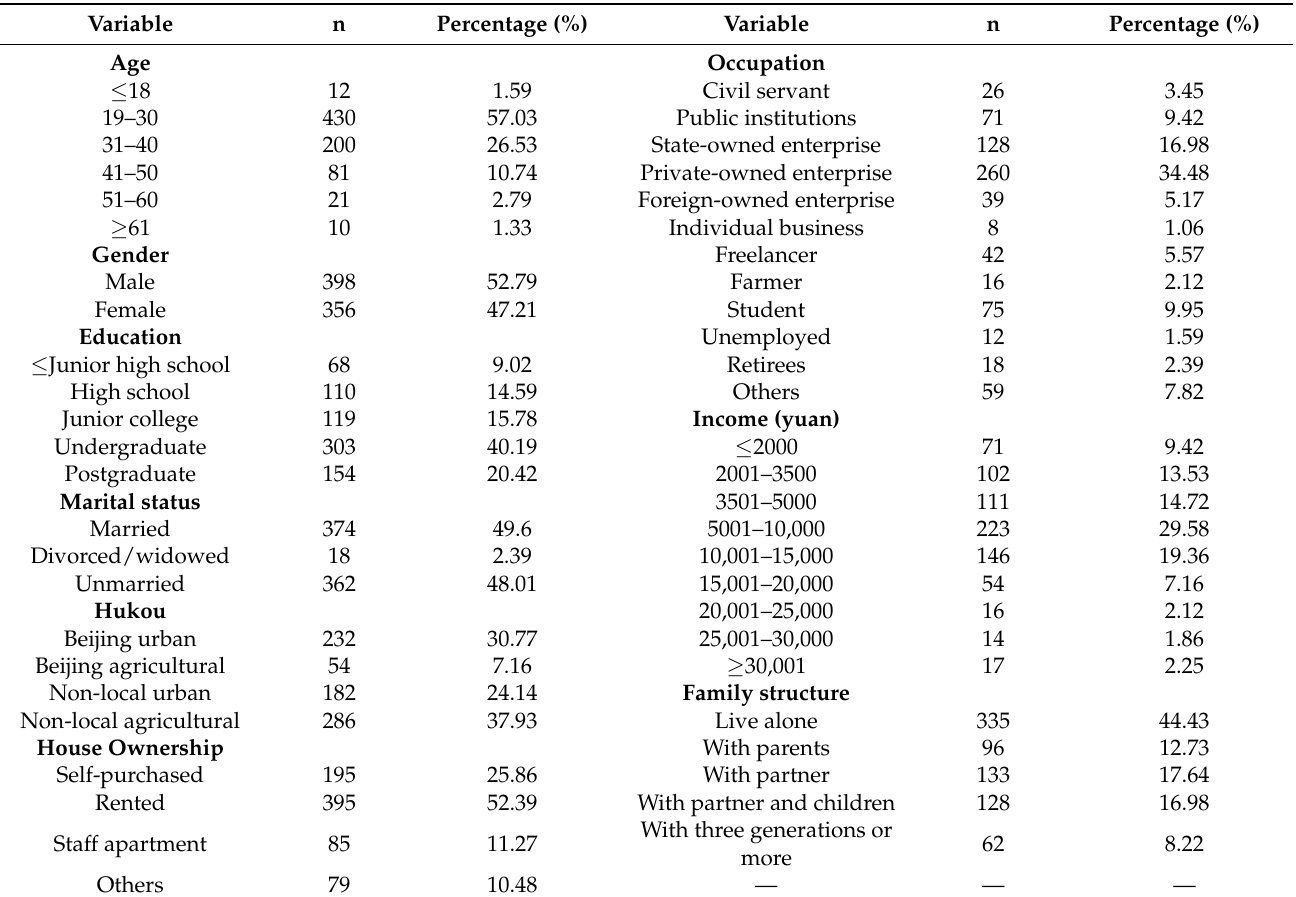
Table 1. Demographic characteristics of the sample.